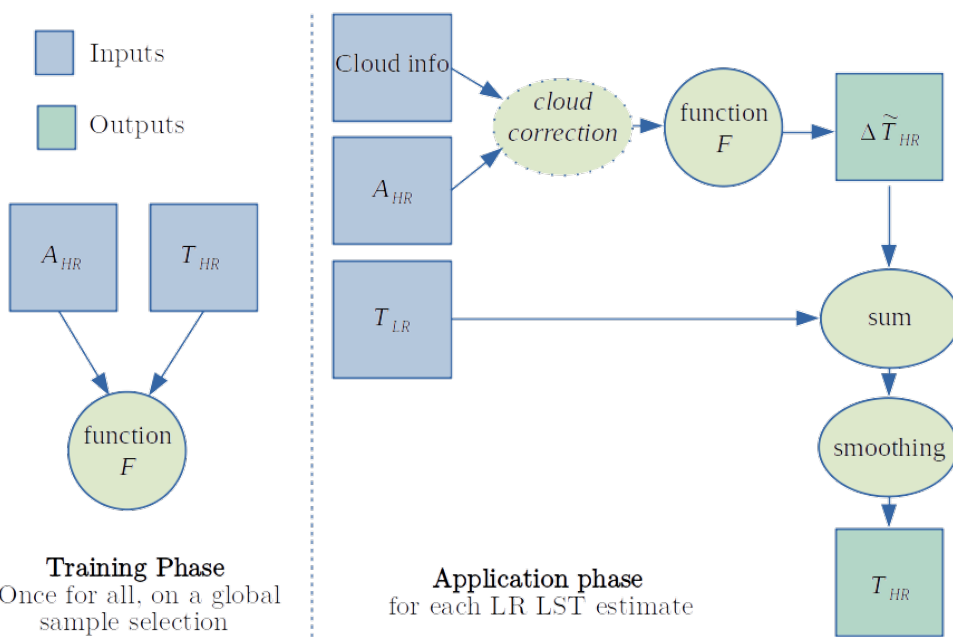
Figure 6. Schematic representation of the downscaling methodology, on the left for the training phase, on the right the application